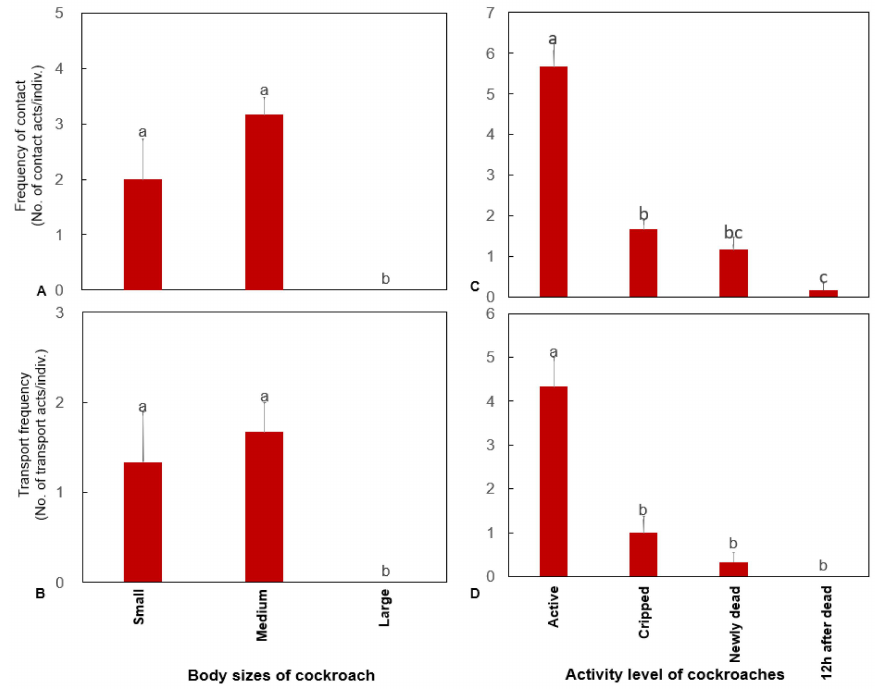
Figure 3. The frequency of touch ( A , C ) and transport ( B , D ) by H. venator for prey with different body sizes and activity levels (mean ± SE). Bars with the same letter are not significantly different at the 0.05 level (Kruskal–Wallis test).